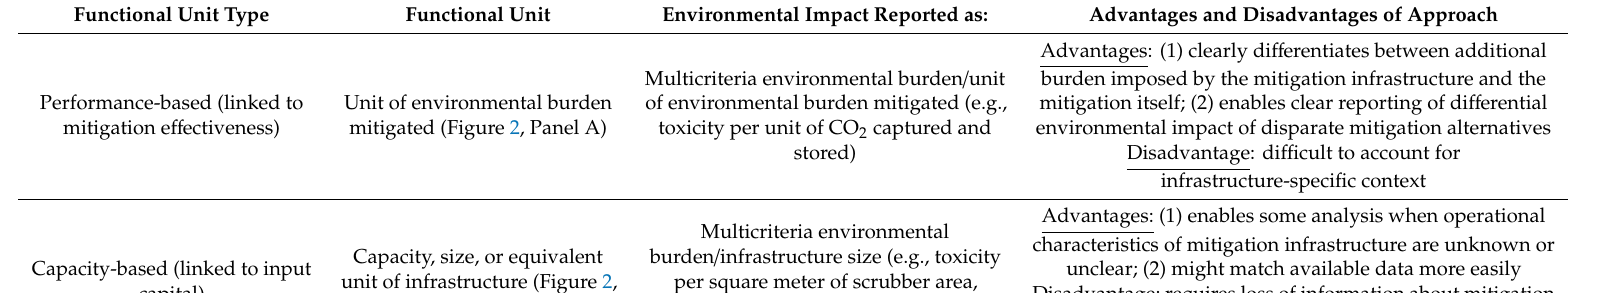
Table 1. Functional unit approaches and examples in the context of carbon capture and storage